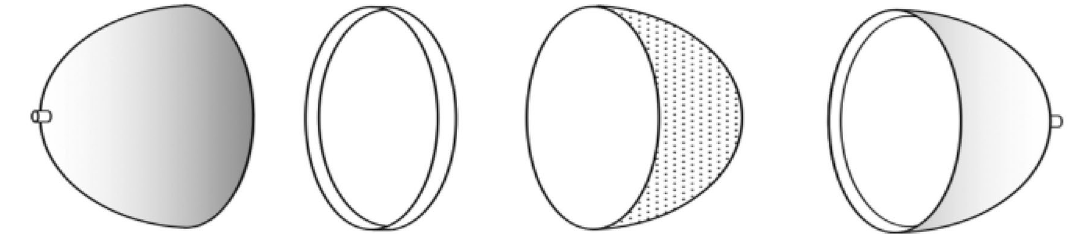
Fig. 1 The components of a diaphragm tank [3]